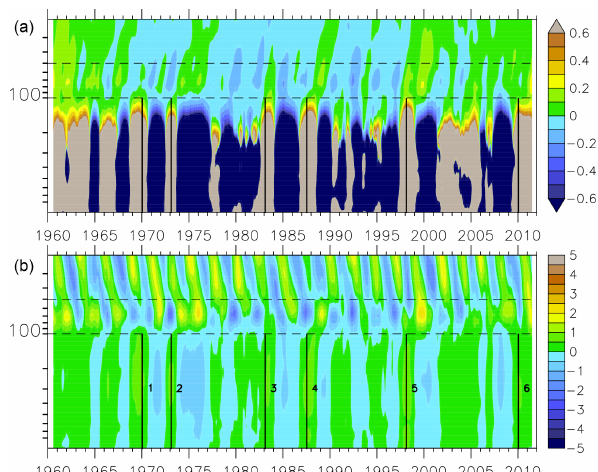
Figure 9. (a) Temporal evolution of moisture anomalies (ppmv). (b) Temporal evolution of temperature anomalies (K) in the tropical region (12-month running mean), derived from the RC1 simulation. Strong El Niño events are labelled similarly to Fig. 8. The altitude range covers the pressure levels from 900 to 30hPa. The dashed lines mark the region between 100 and